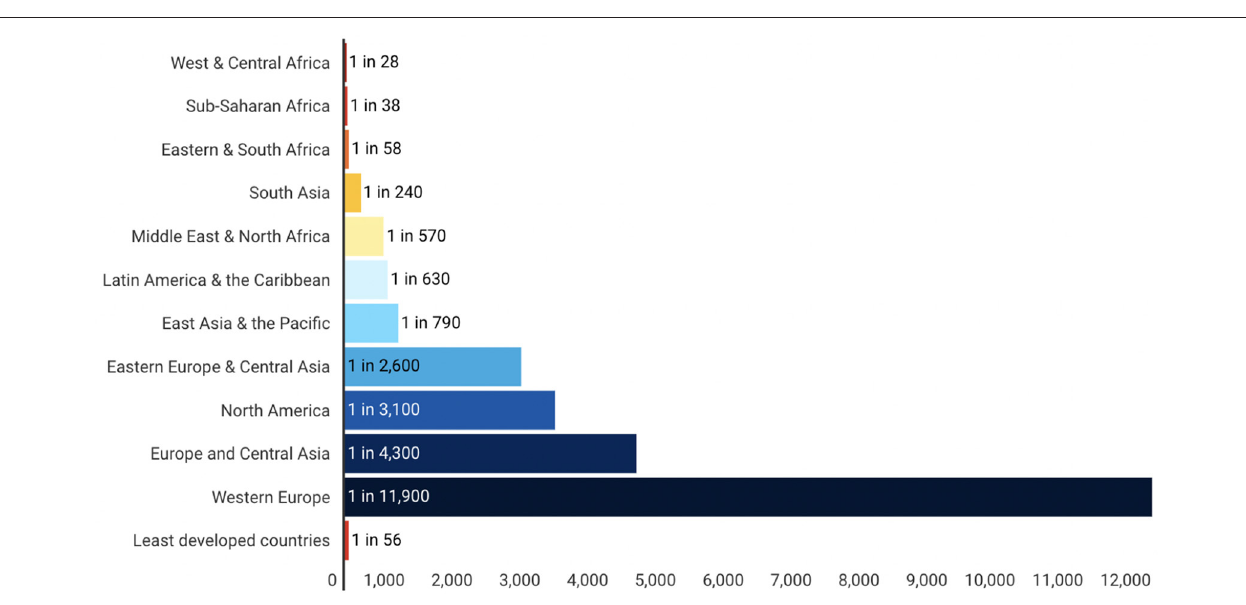
FIGURE 3 | Lifetime risk of maternal death: 1 in X, By region/group. Source: WHO, UNICEF, UNFPA and the World Bank, Trends in Maternal Mortality: 2000 to 2017, WHO, Geneva, 2019. |UNICEF Data: Monitoring the situation of children and